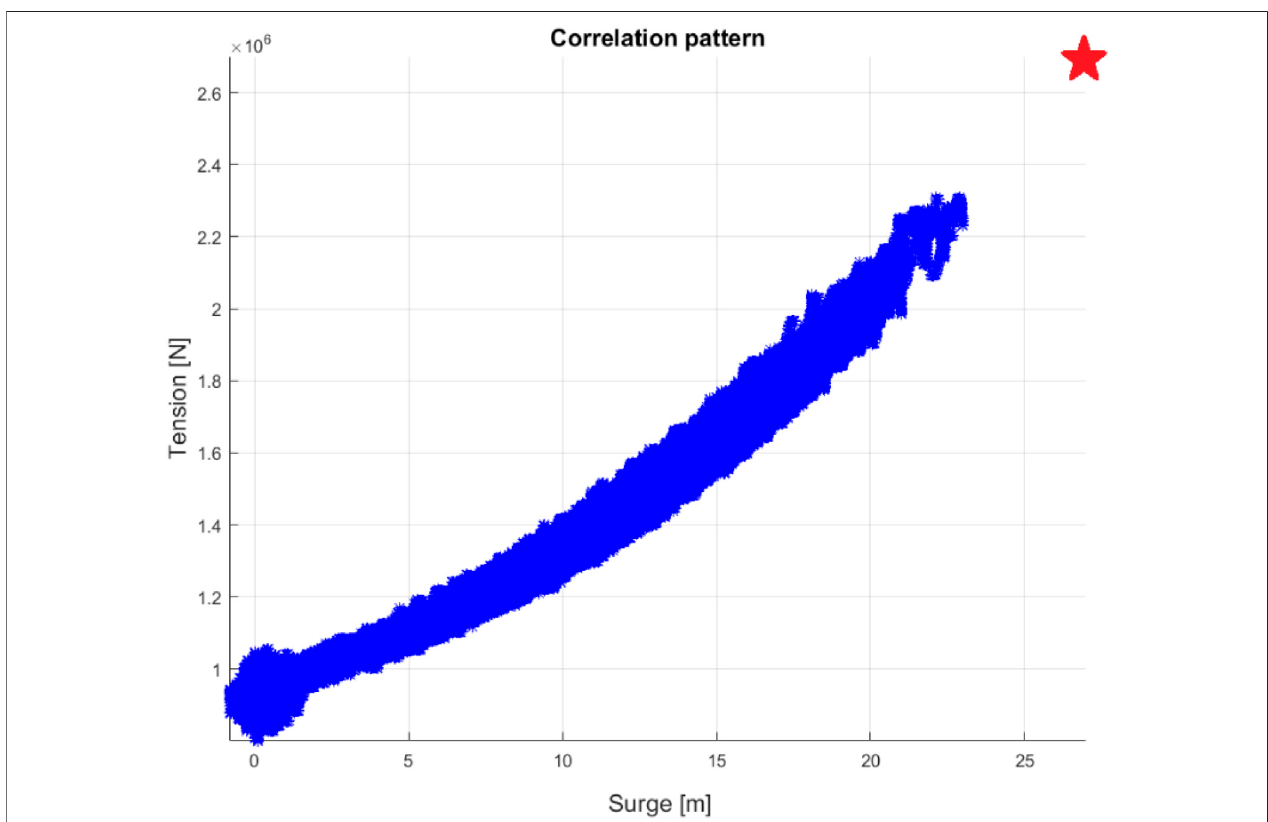
FIGURE 4 | Phase space between simulated Surge and Tension FWT responses. Red star indicates predicted extreme coupled response value.